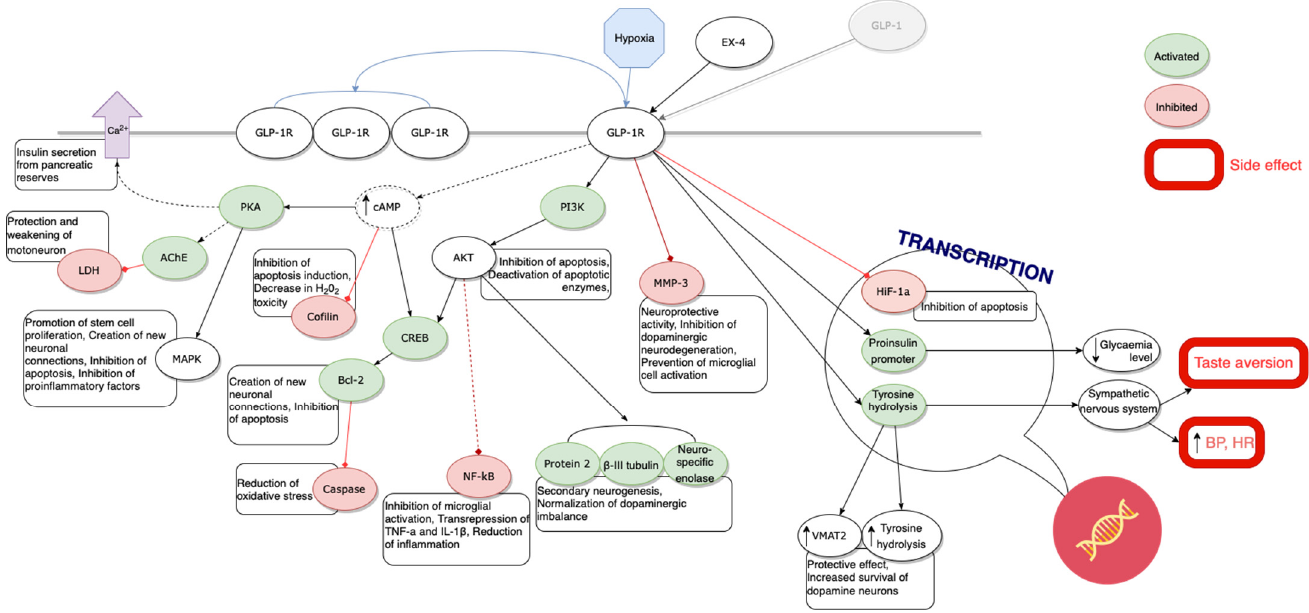
Figure 2. Summary of the presented mechanisms.